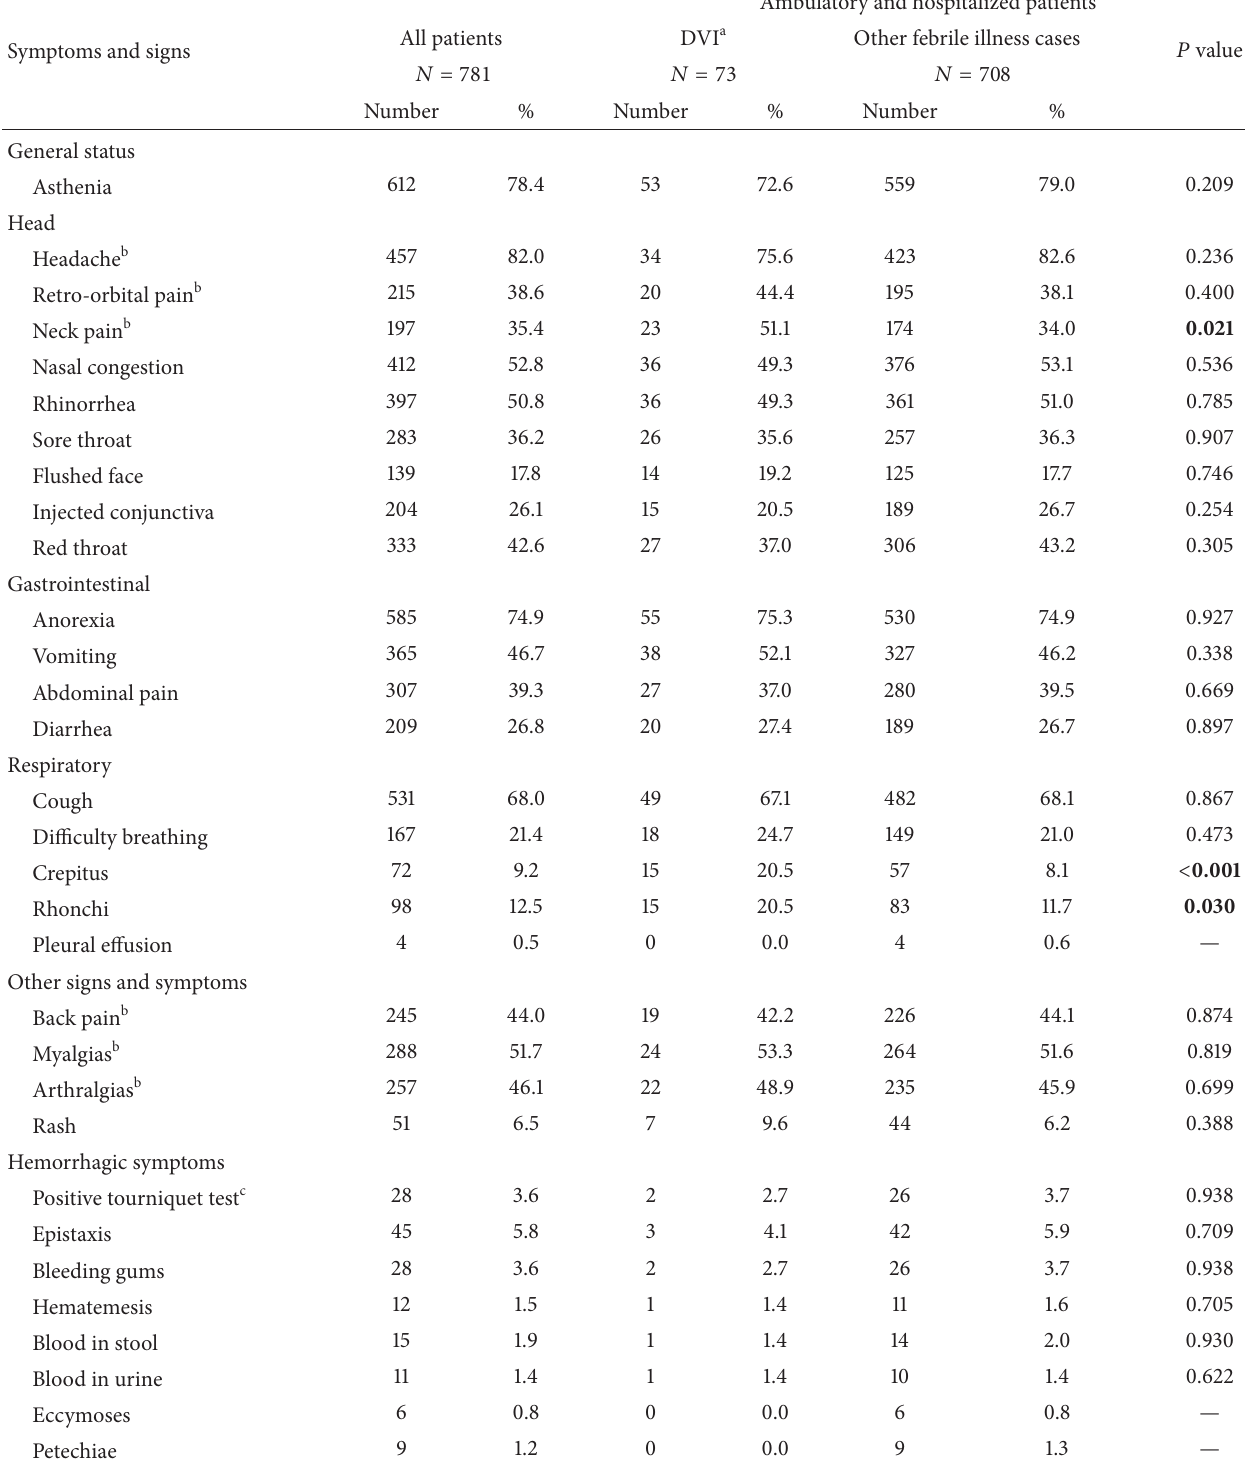
Table3:Comparisonoftheclinicalsymptomsandsignsofambulatoryandhospitalizedpatientswithlaboratory-confirmeddengueinfections and other febrile illnesses. Medellin, Colombia, March